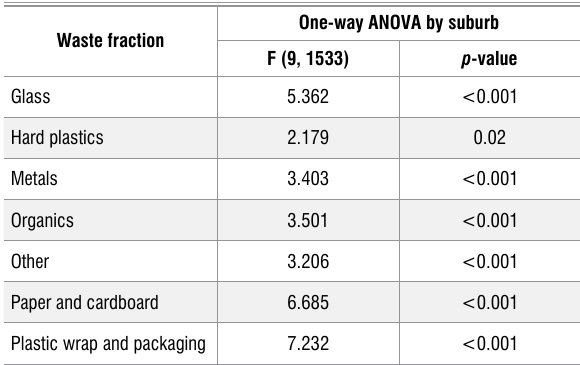
ANOVA comparing differences in means across suburbs for